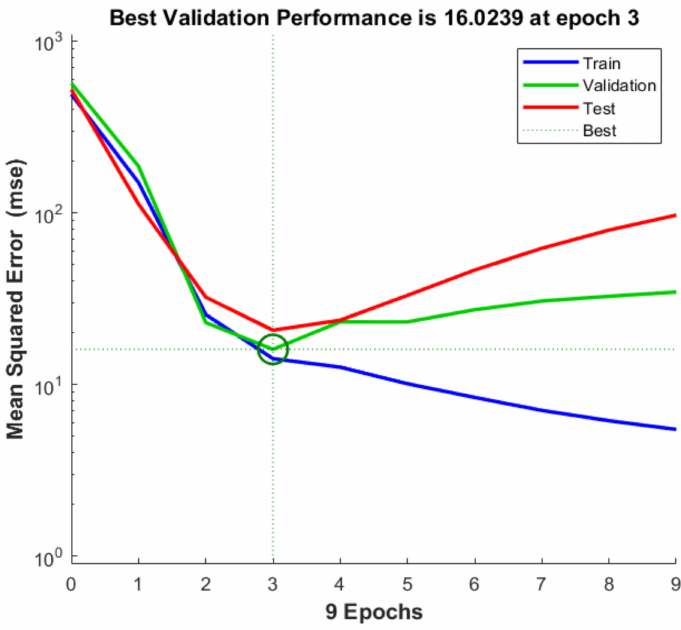
Figure 6. Result of training progress and best validation performance (15 hidden layer).